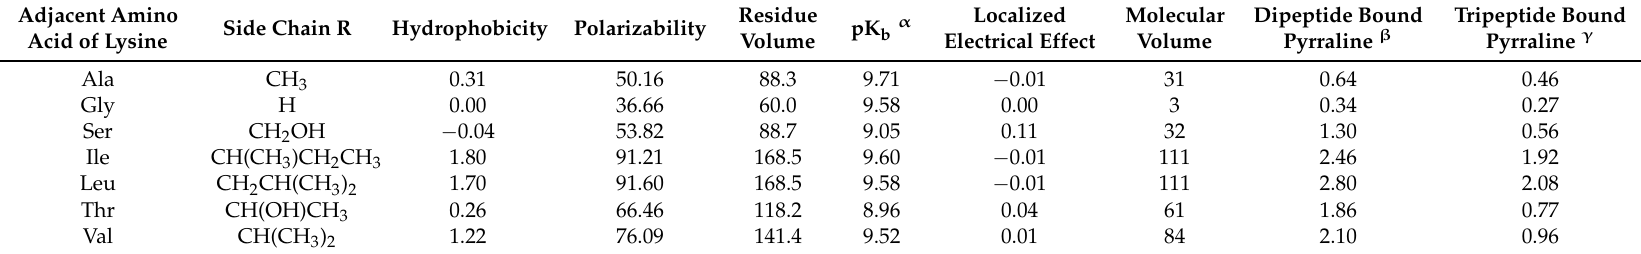
Table 1. Side chain physicochemical parameters (6-parameters set) for the amino acids adjacent to lysine and the yield of peptide bound pyrraline. Adjacent Amino Acid of